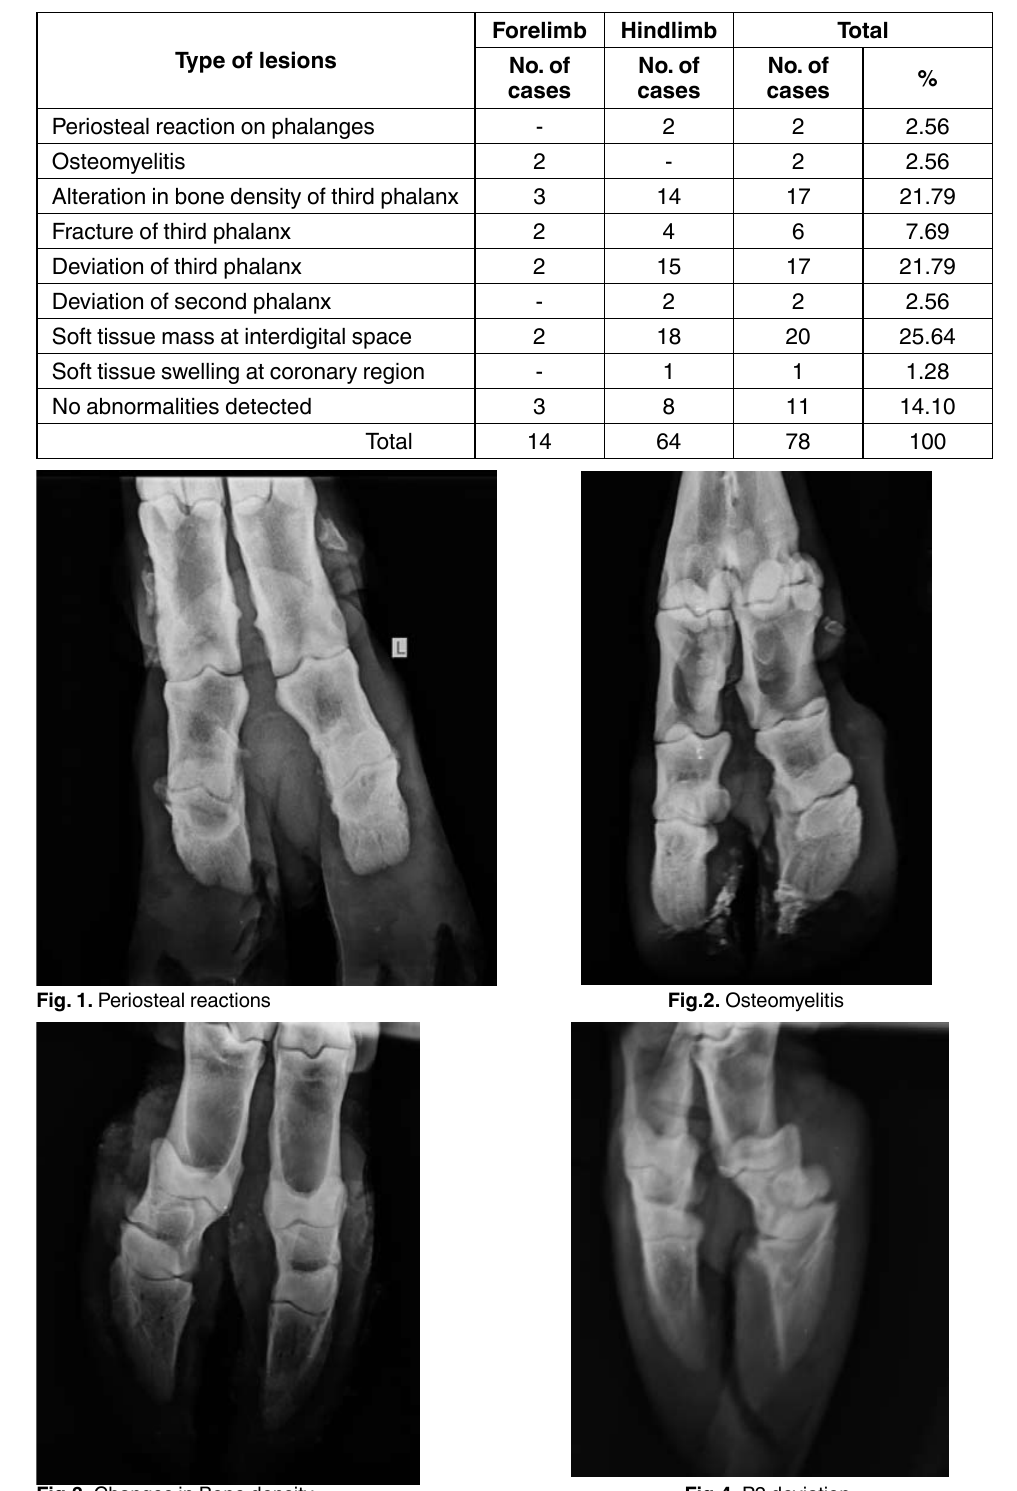
Fig.3. Changes in Bone density Fig.4. P2 deviation